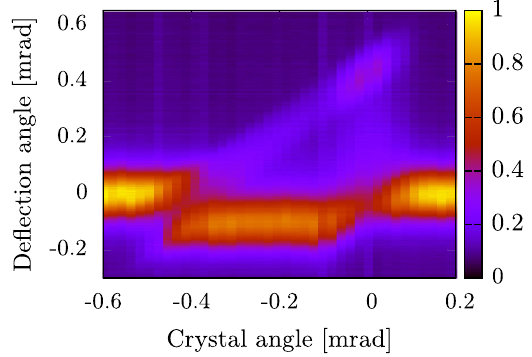
FIG. 5. The probability density relative to the maximum probability density of the deflected particles as a function of the crystal angle for the case of 4.2 GeV electrons.